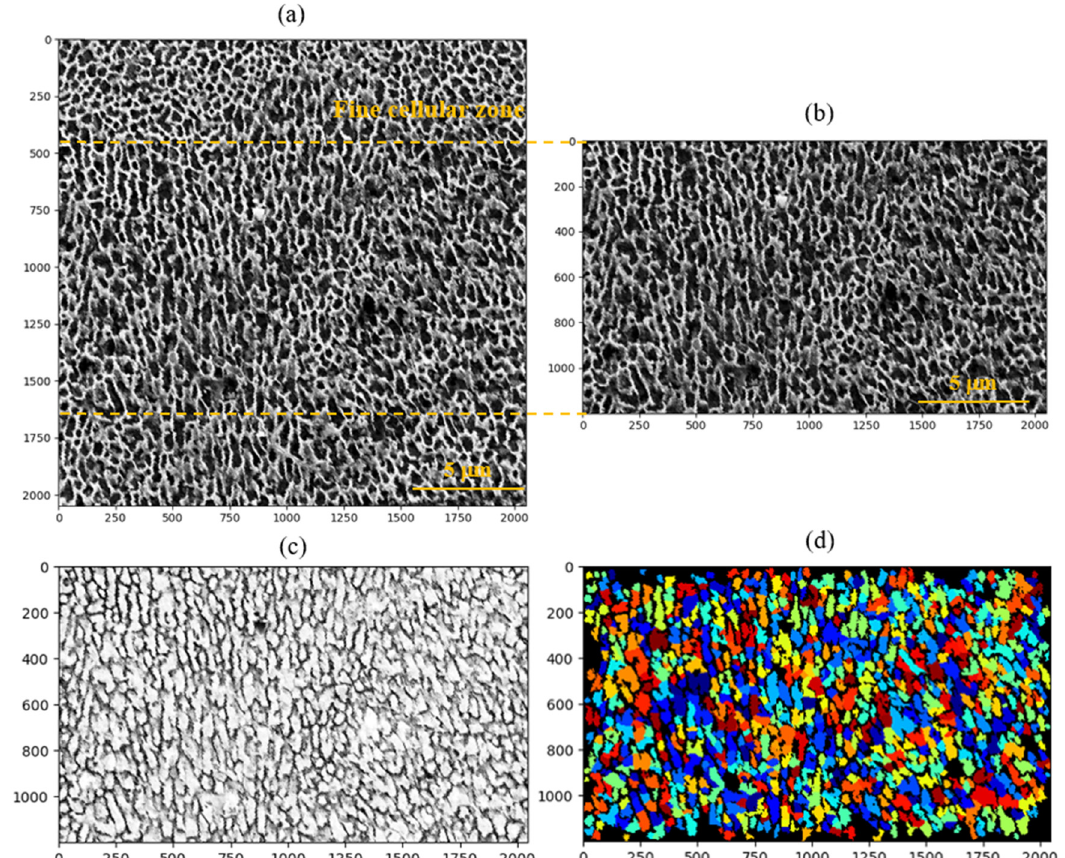
Figure 9: Heat a ff ected zone cellular structure cell detection: ( a ) subgrain cellular structure of CNTs/AlSi10Mg nanocomposites, ( b ) the HAZ coarse cellular zone, ( c ) inversed gray image of the HAZ coarse cellular zone and ( d ) the HAZ coarse cellular zone cell segmentation shows high fi delity representation of the cell shape and